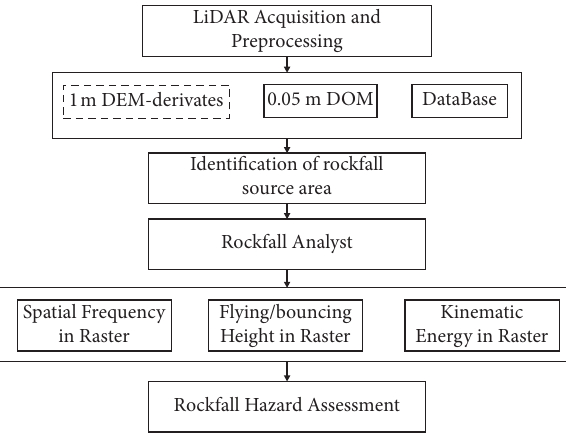
Figure 2: Rockfall hazard assessment workflow using airborne LiDAR and Rockfall Analyst.